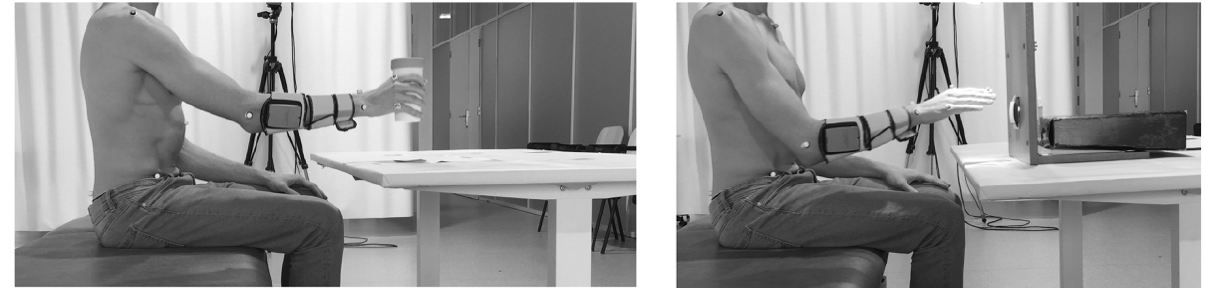
Figure 4. Representation of two tasks of different levels of motor control complexity assisted by multifield FES, drinking task (on the left ) and turn on the light tasks (on the right ).